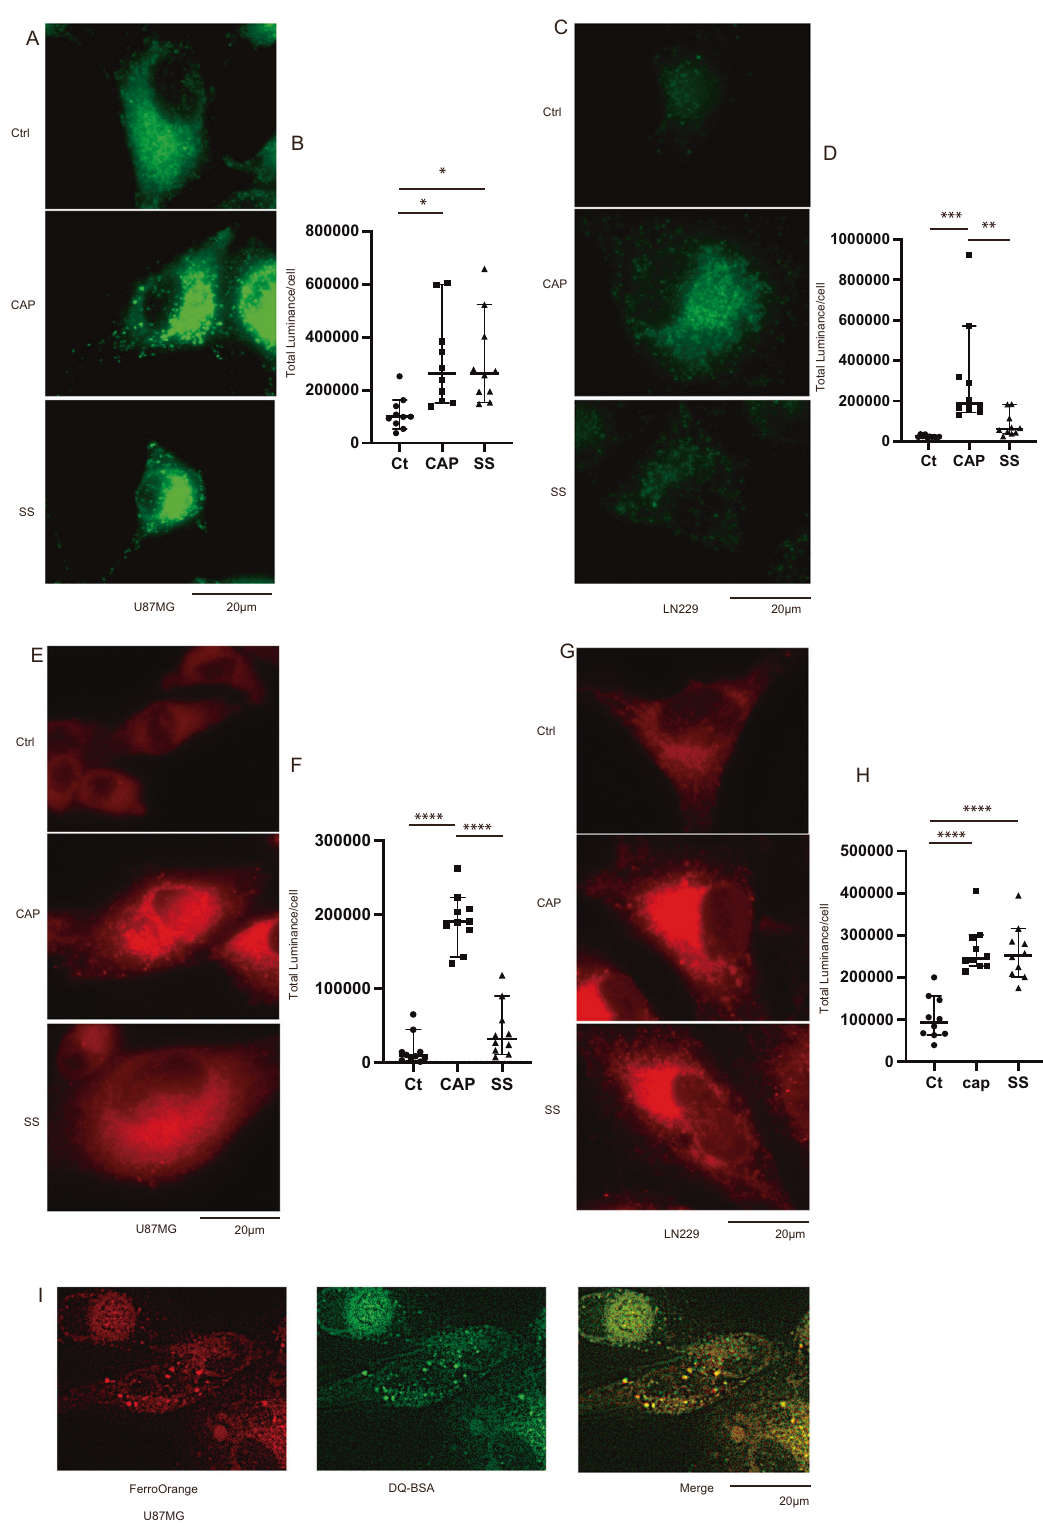
Fig. 4 Induction of lipid radical accumulation by CAP. A In U87, LipiRADICAL luminance increased after treatment with CAP and SS (observed after 72 h) and B quanti fi cation of total luminance of LipiRADICAL Green. C LipiRADICAL luminance showed an increase in the CAP and SS groups in LN229 and D quanti fi cation of total luminance of LipiRADICAL Green. E Luminance of FerroOrange showed an increase in the CAP and SS groups in U87 and F quanti fi cation of total luminance of FerroOrange. G Luminance of FerroOrange showed an increase in the CAP and SS groups in LN229 and H quanti fi cation of total luminance of FerroOrange. I In U87, the luminance of FerroOrange and DQ-BSA colocalized. Values are presented as mean ± SD ( N = 10). Ordinary one-way ANOVA with Tukey ’ s multiple comparisons test was performed on control vs. CAP and control vs. SS. * p < 0.05, ** p < 0.01, *** p < 0.001, **** p <